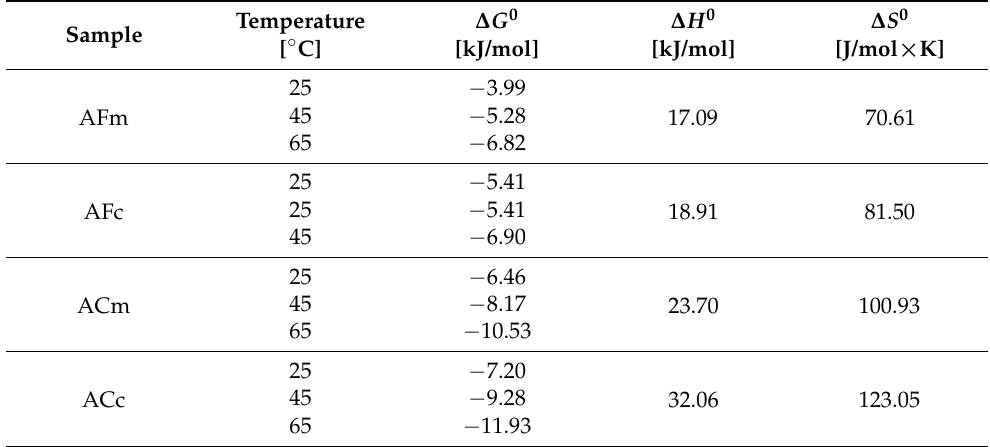
Table 7. Thermodynamic parameters characterizing the adsorption of methyl red sodium salt on the biocarbons studied.